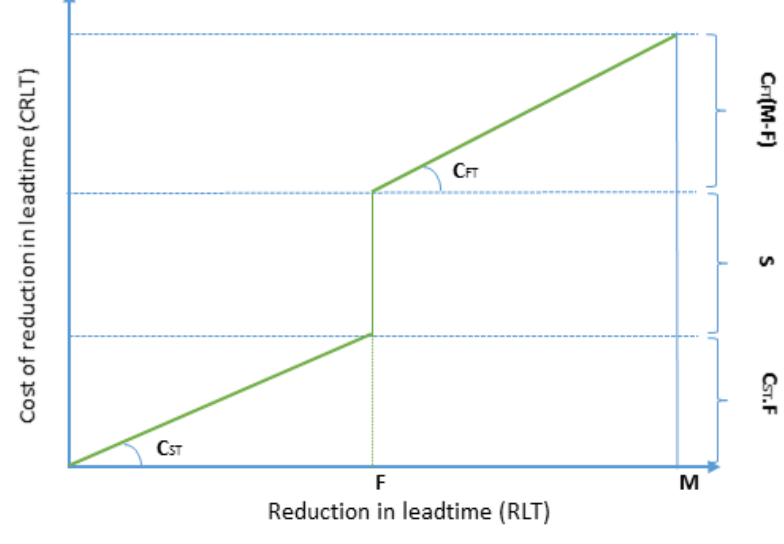
Figure 1. The function of cost of reduction in lead-time